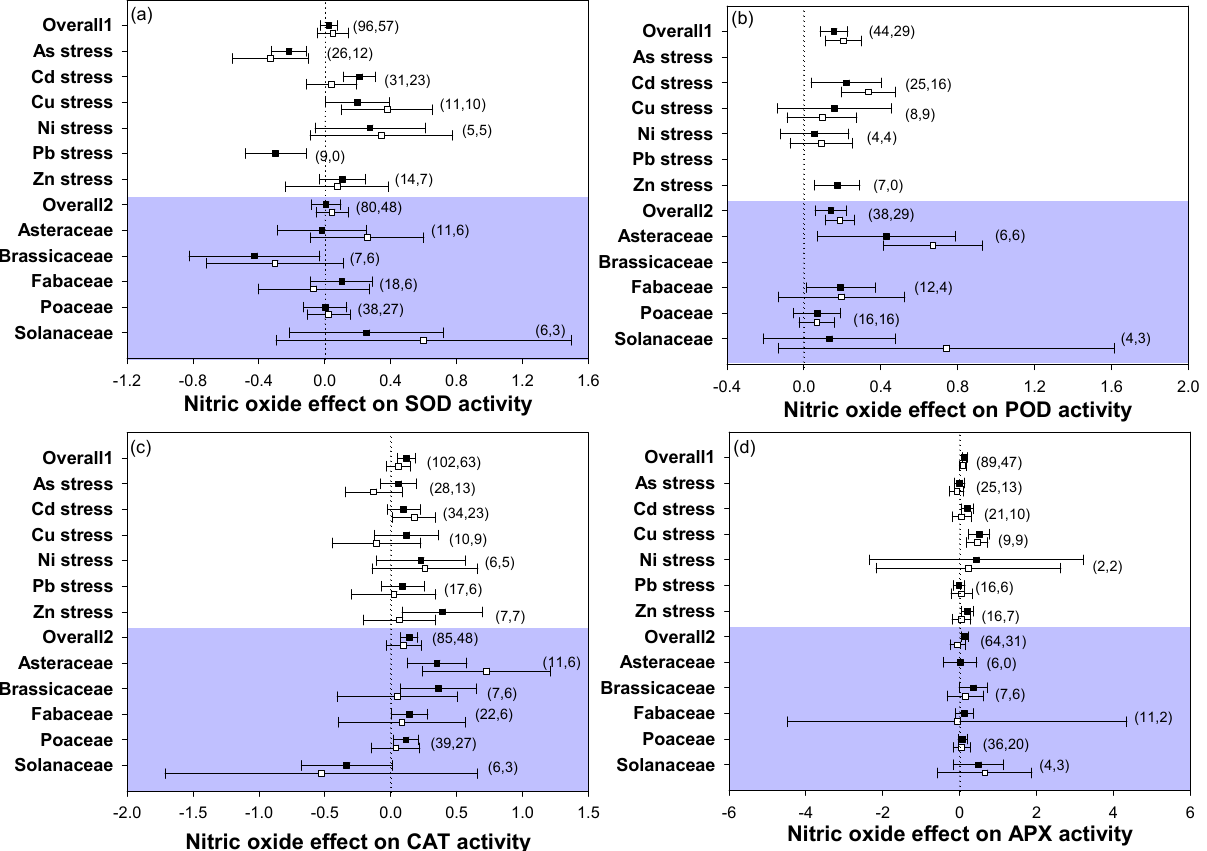
Figure 3. Plots of effect sizes for the effect of NO on enzymatic antioxidant activities of heavy metal-stressed plants, including ( a ) SOD activity, ( b ) POD activity, ( c ) CAT activity, and ( d ) APX activity. Overall1 and overall2 indicate the mean (summary) effect size of all metal stresses and plant families, respectively. Black and white dots indicate the mean effect sizes for factor groups of leaf and root responses, respectively. The numbers in brackets specify the number of data points. The black square block with the error bar indicates the mean response size with a 95% confidence interval, and the dashed vertical line shows zero effect.